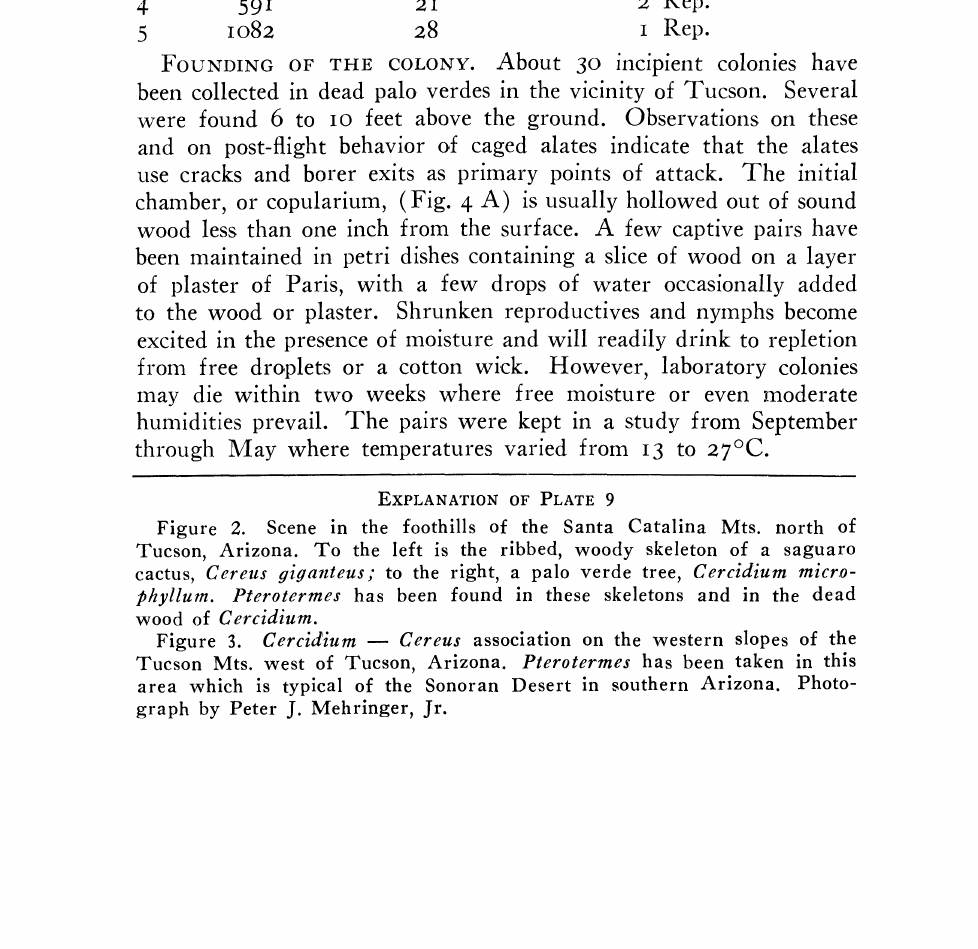
Table 2. Composition of five colonies of Pterotermes occidentis from Arizona. It was impossible to determine whether colonies No. 4 and were fragments of a single colony in the same log, or whether No. was actually